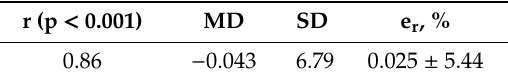
Table 1. Performance of the proposed method.